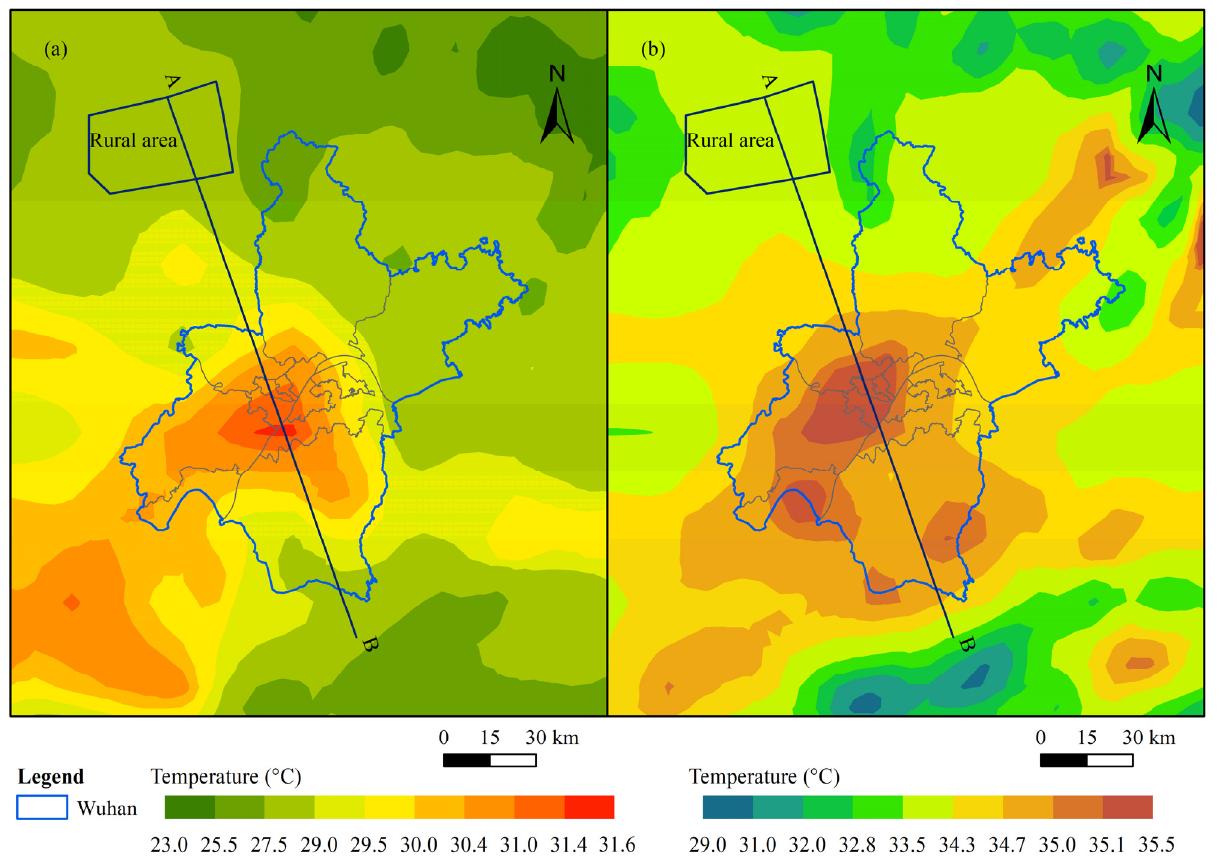
Figure 2. The mean air temperature isotherm of an extended area including the city of Wuhan from 17 July to 23 July. ( a ) Nighttime; ( b ) daytime.